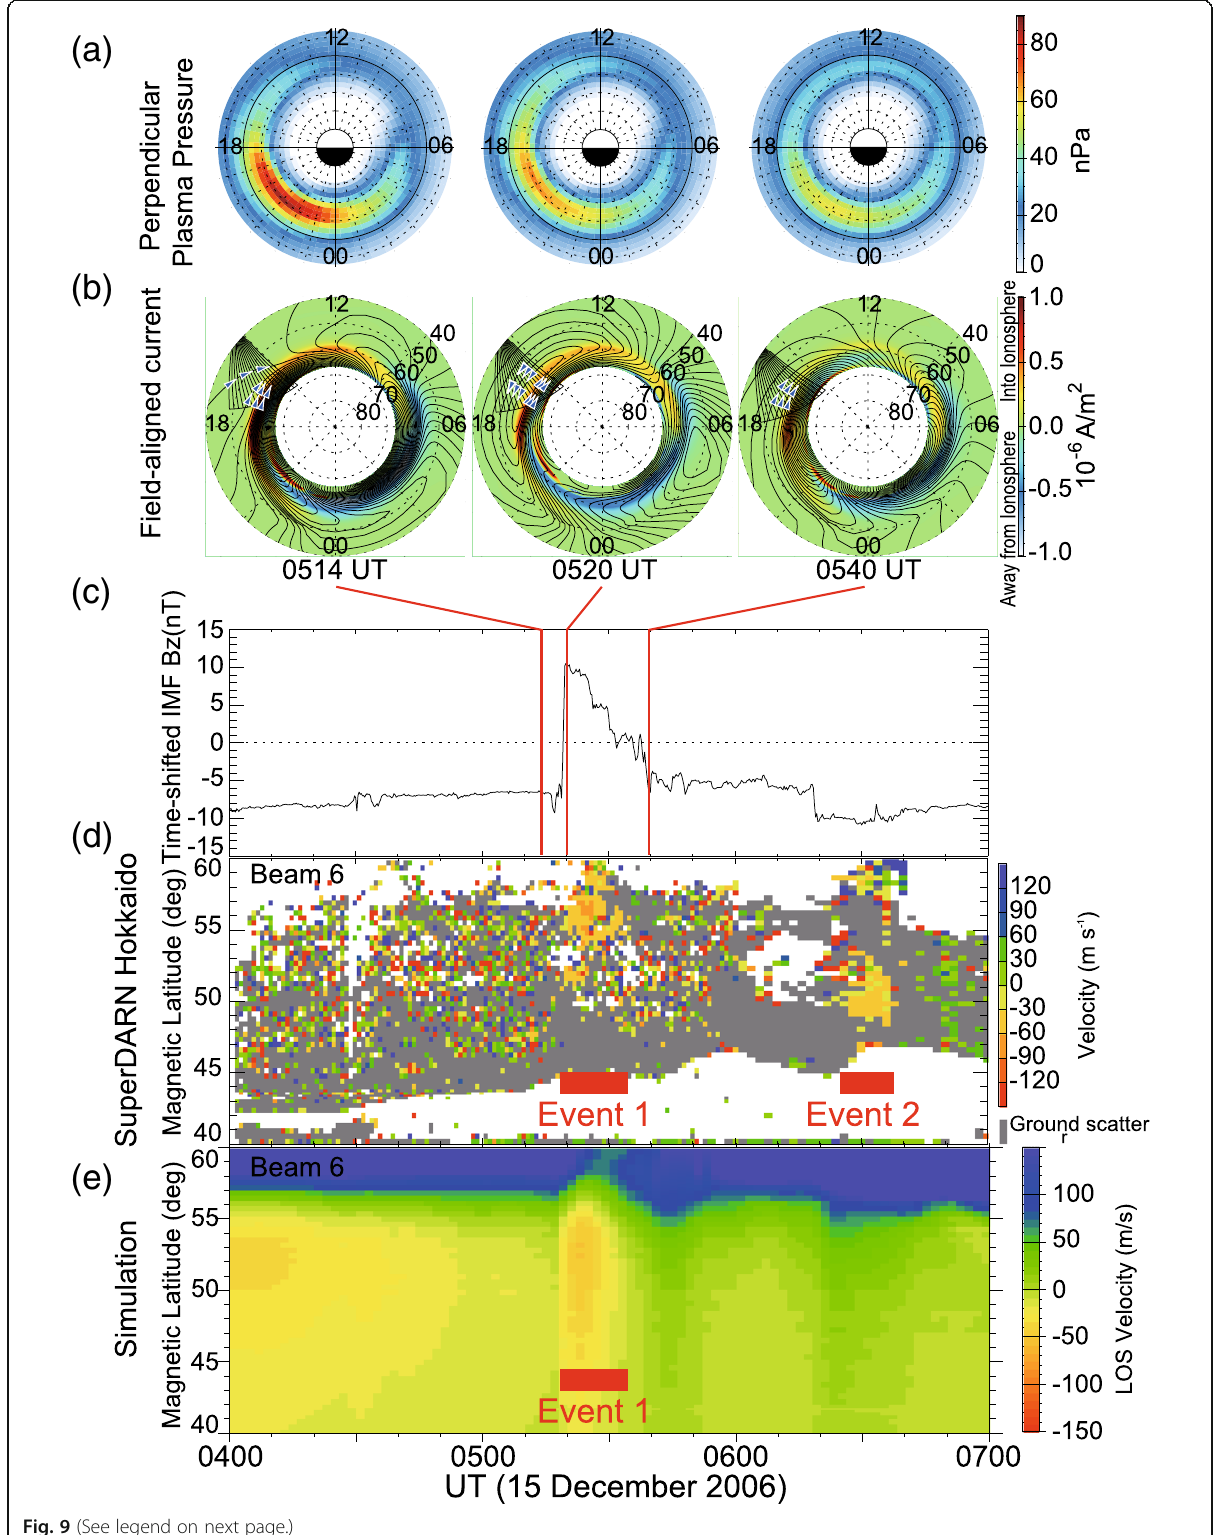
Fig. 9 (See legend on next